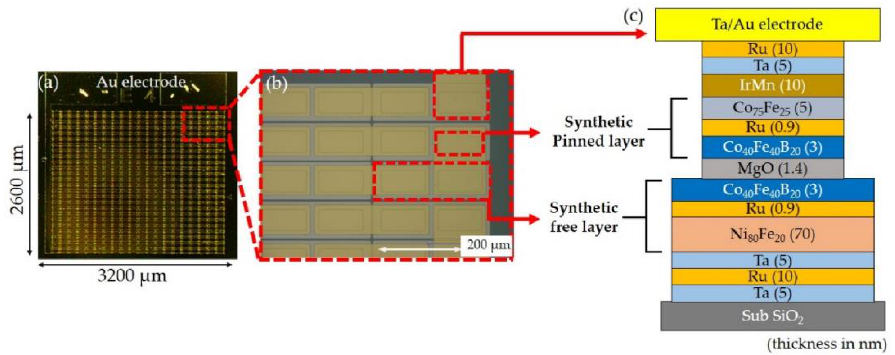
Figure 5. ( a , b ) Microscopy of TMR multilayer system consists of 500 MTJs. ( c ) Schematic diagram of TMR multilayer system. Adapted from [67]. Figure Copyright © 2018 MDPI Publishing, Open Access.